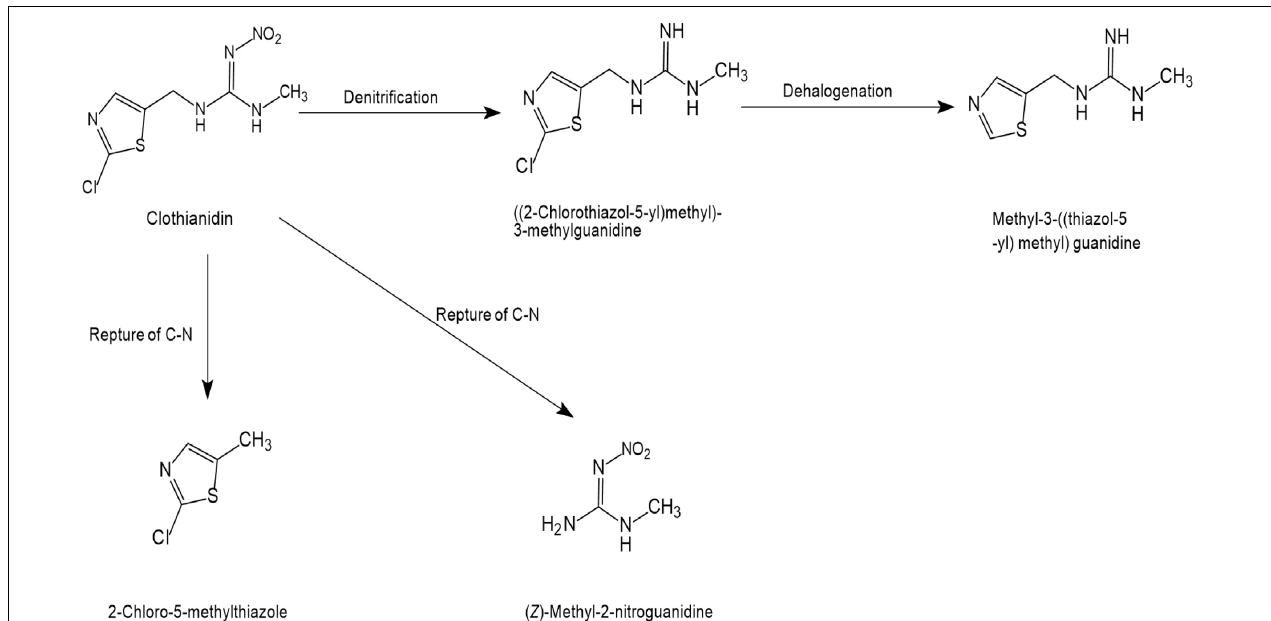
FIGURE 5 | Microbial degradation pathways of clothianidin (based on Parte and Kharat, 2019).